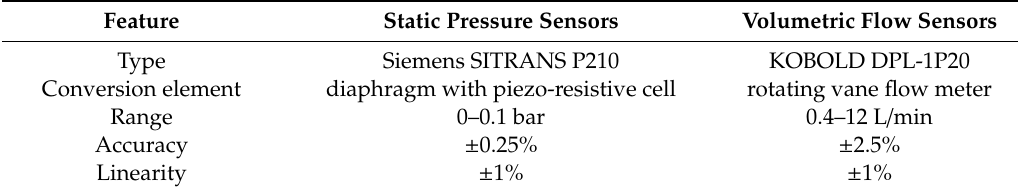
Table 2. Main characteristics of ASTANK2